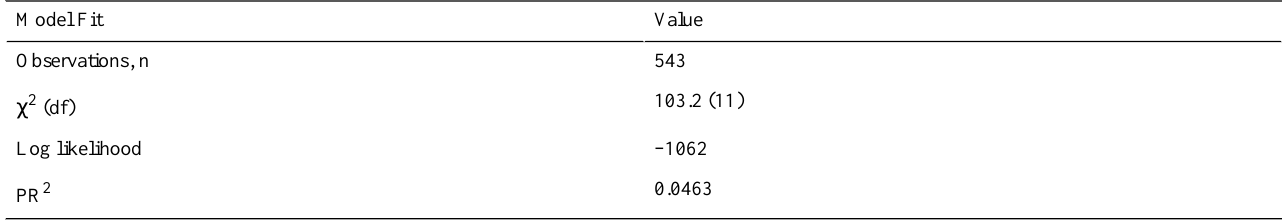
Table 6. Poisson regression